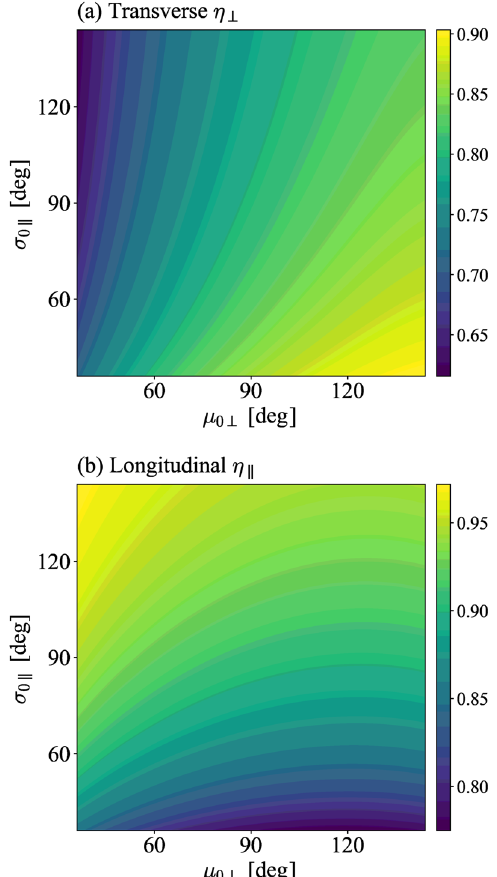
FIG. 9. Rms tune depressions in (a) the transverse direction and (b) the longitudinal direction, under the condition assumed in Fig. 8(a).